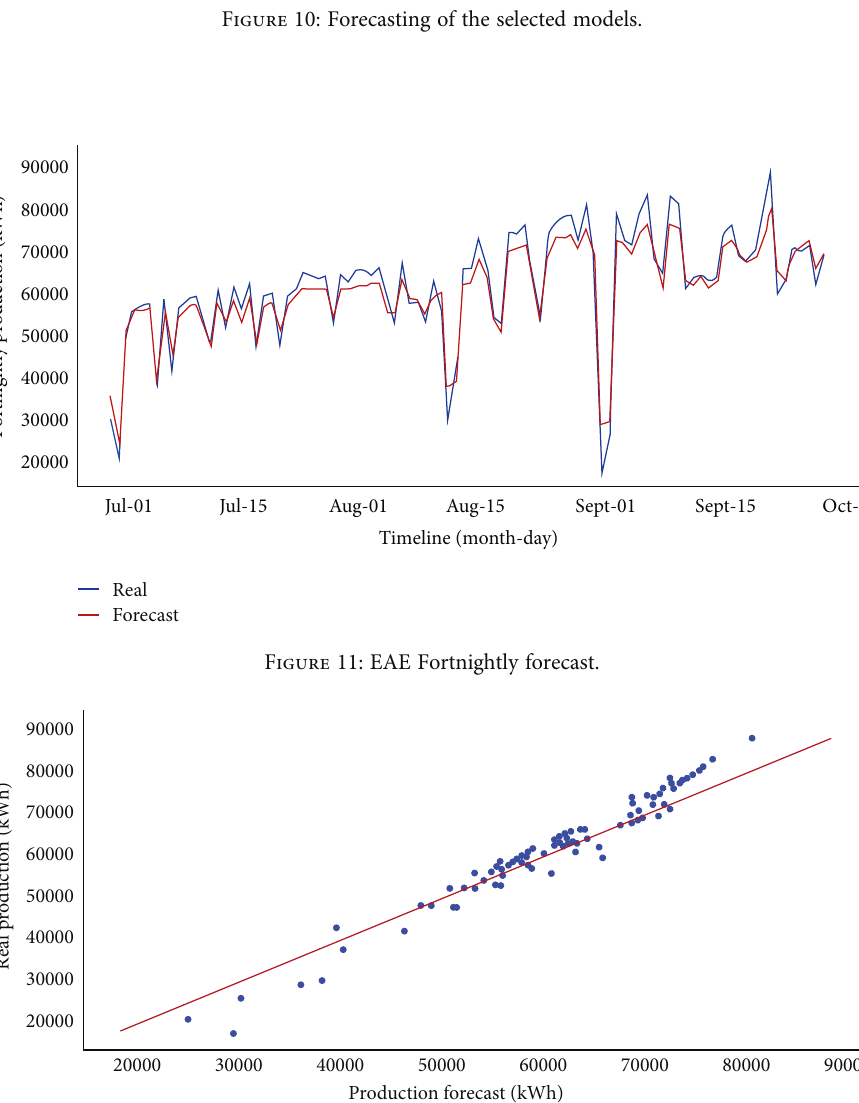
Figure 12: Dispersion of the values of the RNN-ANN model versus the real values.